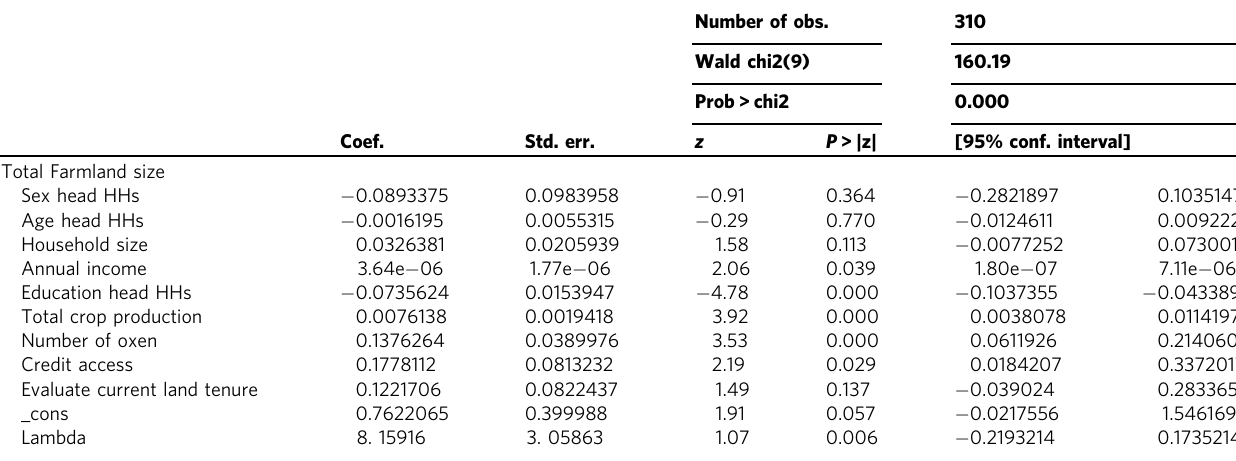
Table 7 Heckman-two-step regression model for total farmland size estimation.